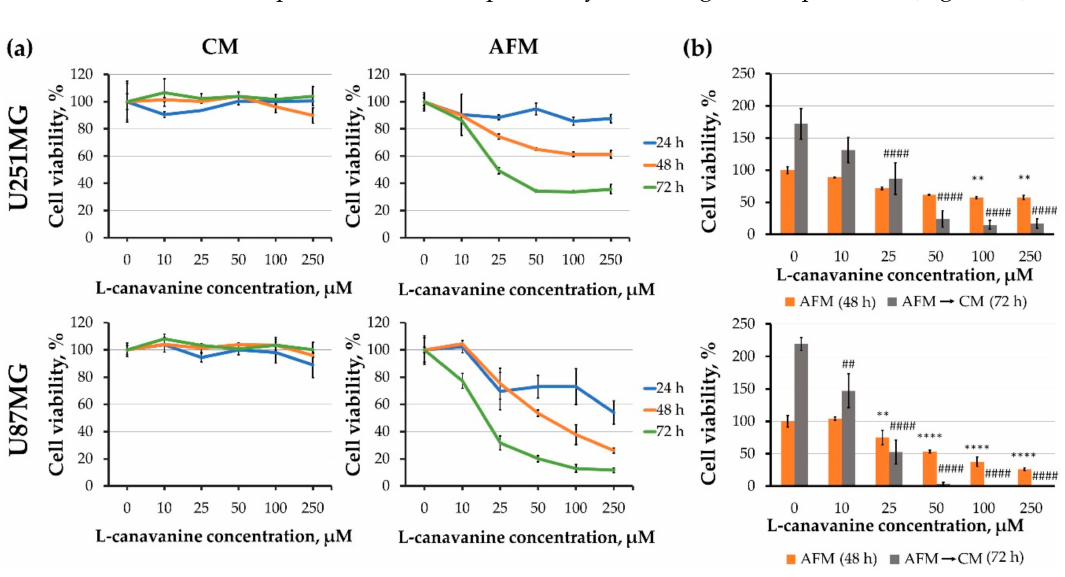
Figure 2. E ff ect of canavanine on glioblastoma cell viability and ability to restore growth upon arginine resupplementation. ( a ) MTS assay for U251MG and U87MG human glioblastoma cells treated for up to 72 h with increasing concentrations of canavanine (CAV) in the complete (CM) or arginine-free (AFM) media. ( b ) After 48 h of treatment, the medium was changed for arginine-containing complete medium (CM), and the cells were cultured for an additional 72 h. Then, growth restoration was assessed using the MTS test. Graphs represent mean values ± SD from three independent experiments. ** p < 0.01, **** p < 0.0001 relative to arginine-free medium (AFM) (control, 100%); ## p < 0.01, #### p <